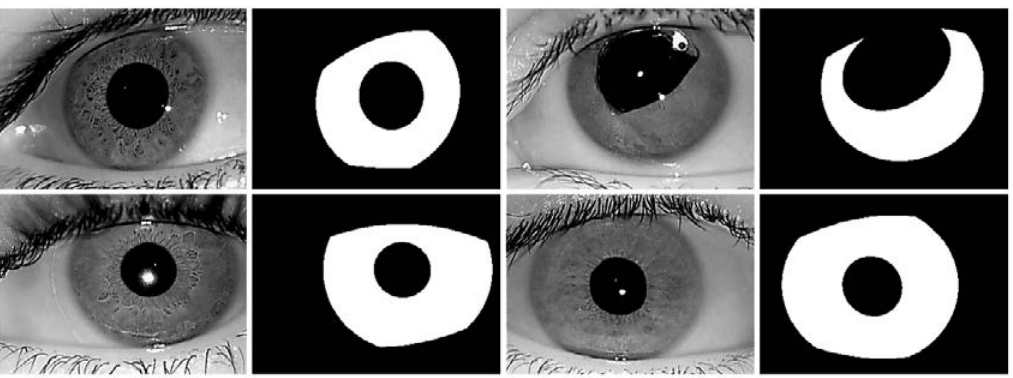
Figure 13. IIT Delhi (IITD) v1.0 sample images with corresponding ground truths.